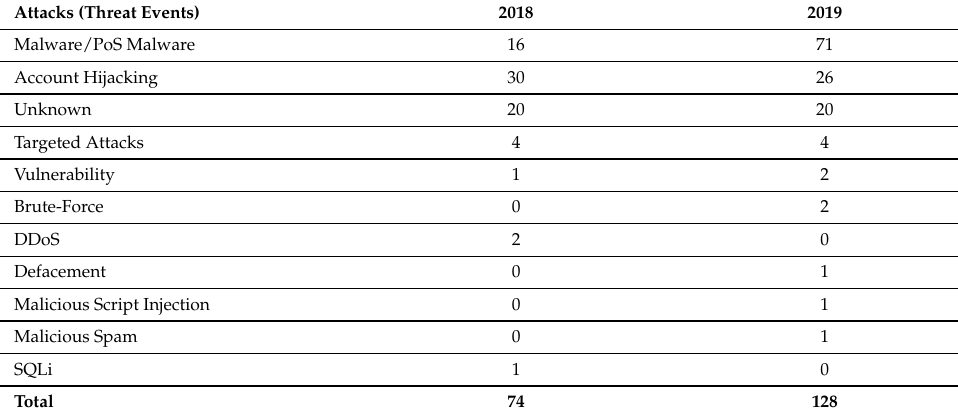
Table 10. Statistics from Hackmageddon.com (Visited 28 January 2021) [65,66] of attacks (threat events) for the “Education” category, 2018 ( n = 74) and 2019 ( n = 128).